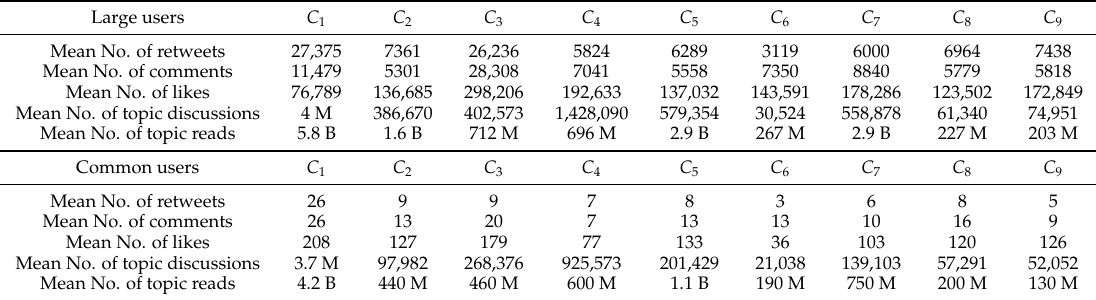
Table 4. Characteristics of nine microblog categories posted by large users and common users.